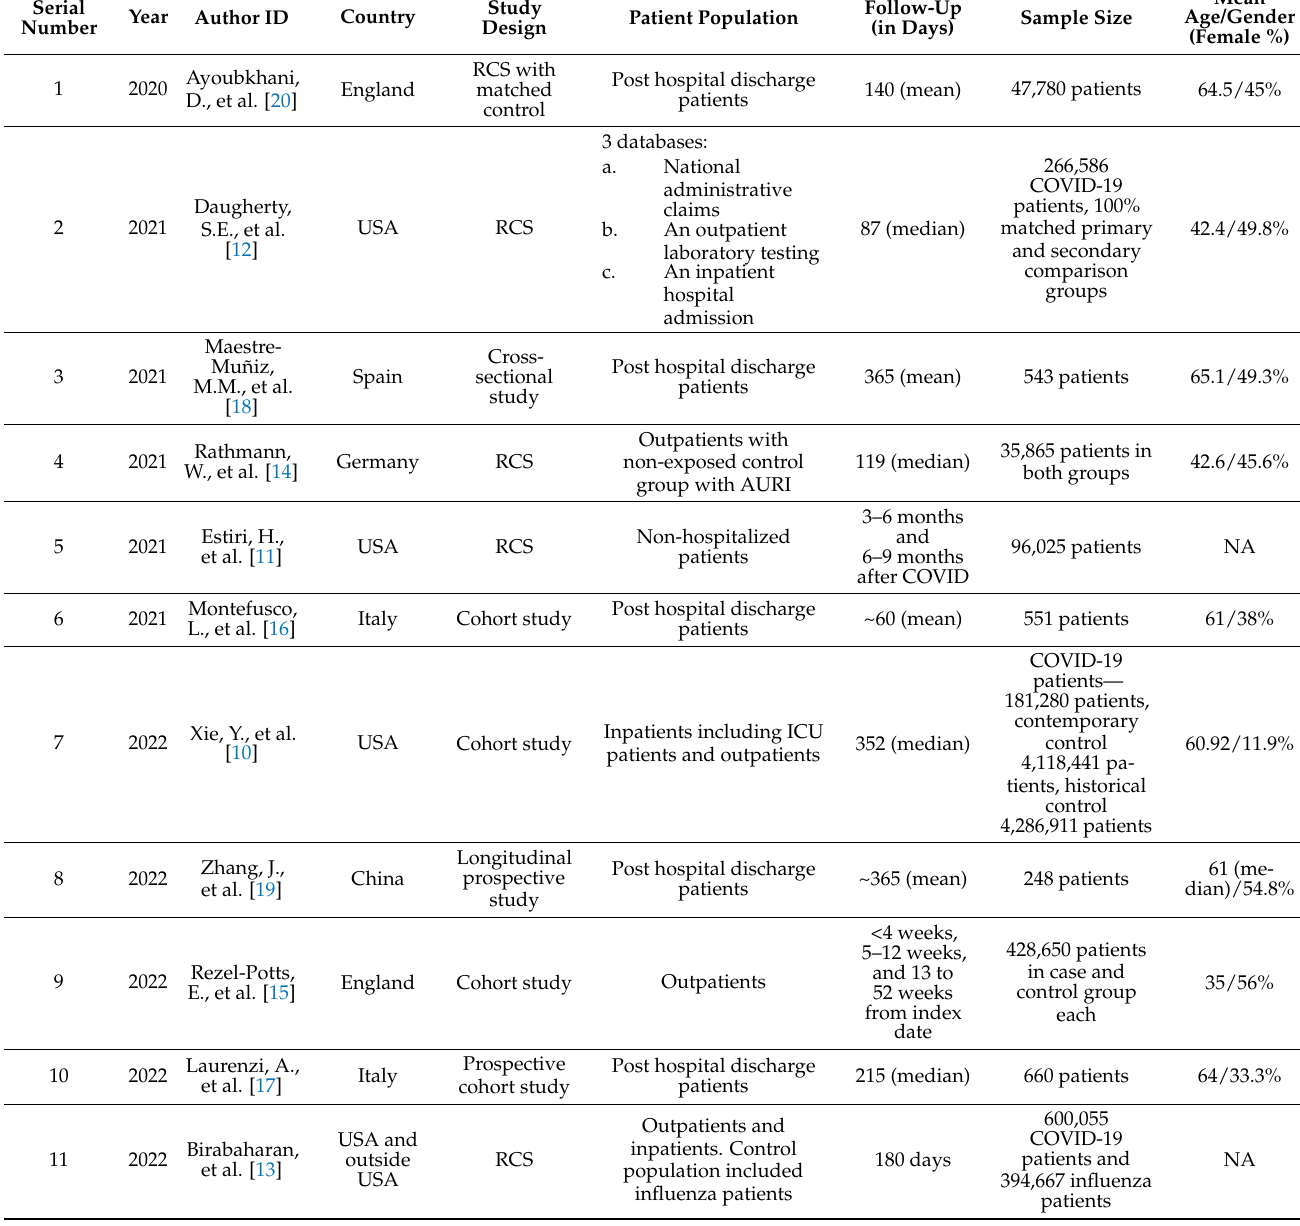
Table 1. Characteristics of included